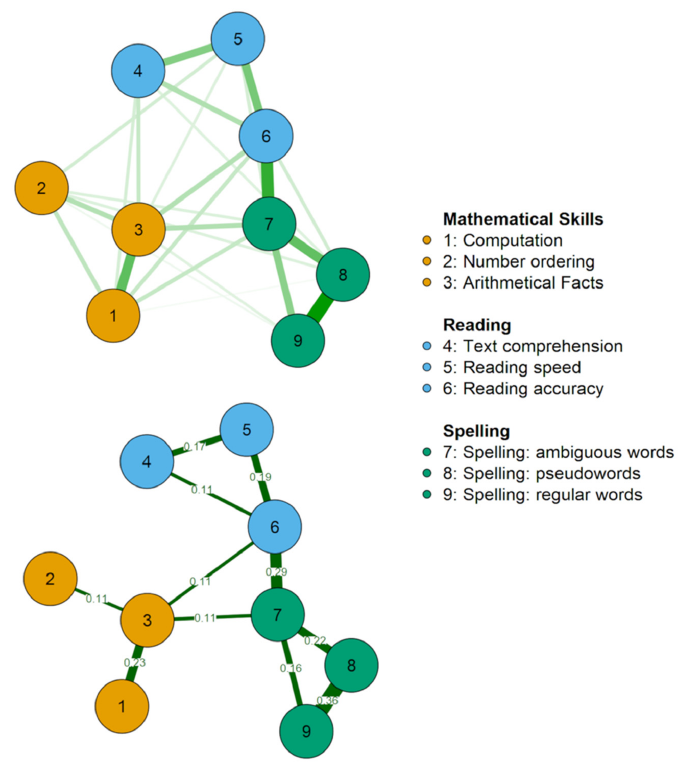
Figure 2. The upper panel reports every edge estimated as different from 0 by the Gaussian Graphical Model, adopting the eBIC Graphical Lasso method. The edges represent regularised partial correlations. The lower panel shows the same network with graphical changes to improve the readability of the most important connections. Specifically, only edges >0.1 are shown. Notably, these edges are also those that emerged as more stable considering the estimated confidence intervals, estimated over 10,000 bootstrap resampling events (see Figure 3). To make it more readable, colour saturation is not scaled according to the edge strength in the lower panel as done in the upper panel. Green lines indicate positive associations. Red lines would have indicated negative associations (none were observed). The nodes indicate the variables as follows: Computation (1); Number ordering (2); Arithmetical Facts (3); Text comprehension (4); Reading speed (5); Reading accuracy (6); Spelling: ambiguous words (7); Spelling: pseudowords (8); Spelling: regular words (9).